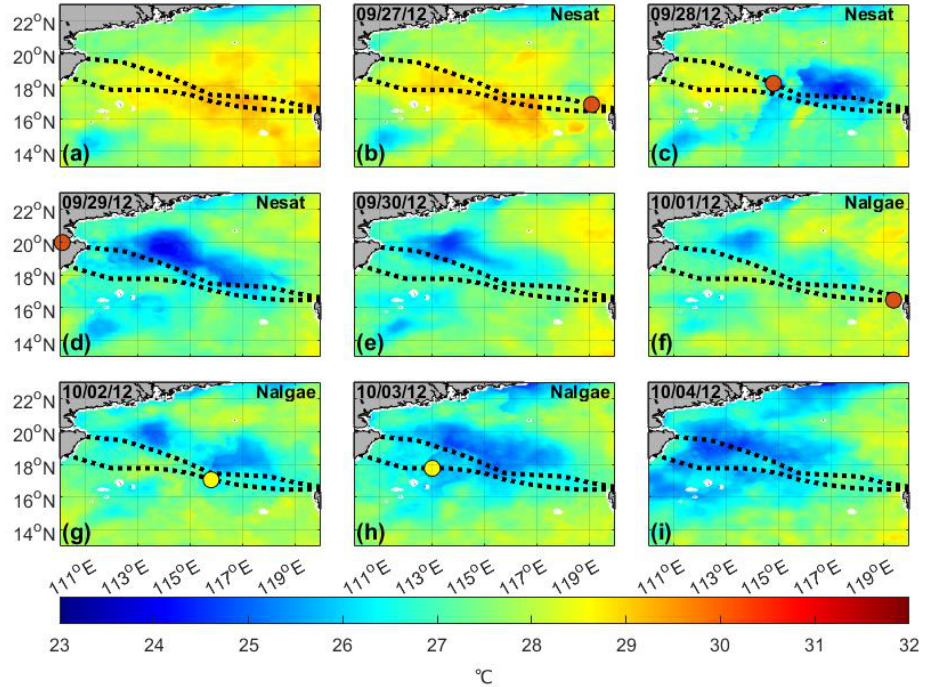
Figure 3. The mean SST in the South China Sea from 24 to 26 September ( a ), and the SST ( ◦ C) when the typhoons passed through the South China Sea ( b – i ) (The discs represent the locations of the typhoons and the color of each disc represents the intensity of the typhoons, following the color categorization in Figure 2a).